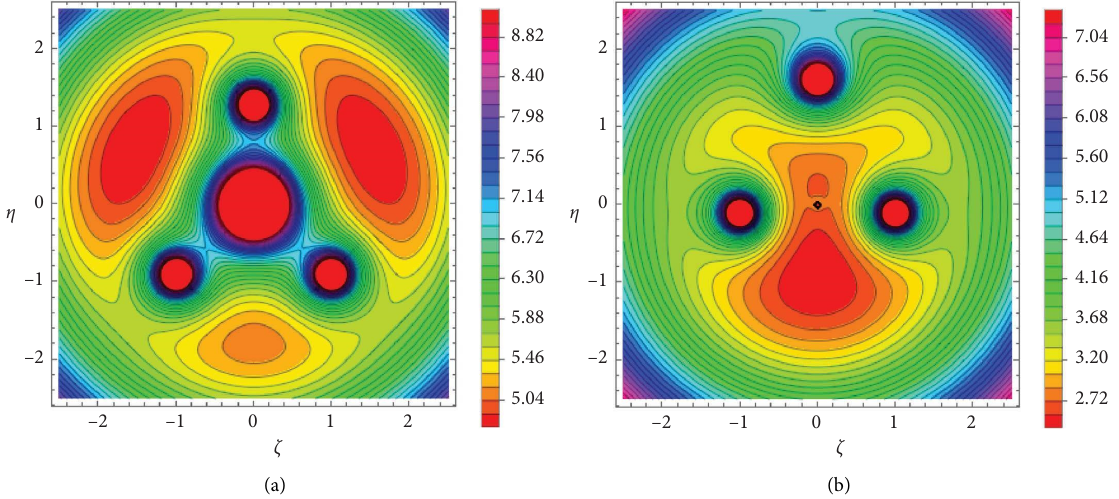
Figure 10: Case III: the evolution of zero velocity curves. (a) μ � 3, (b) μ � 0 .